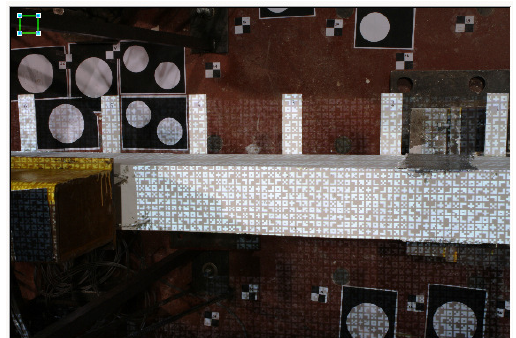
Figure 6. Example of the absence on signalized targets and the presence of a projected random pattern on the surface of the concrete beam during the testing